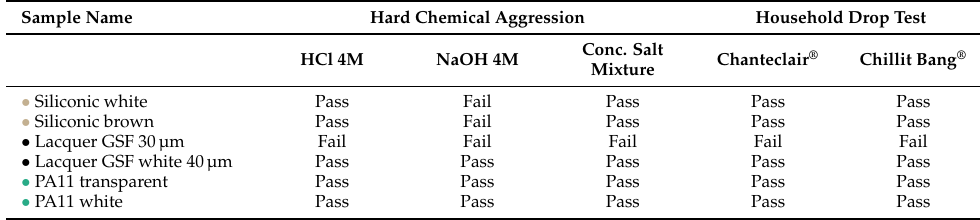
Table 2. Results of harsh chemicals tests for samples passing the first level of tests.